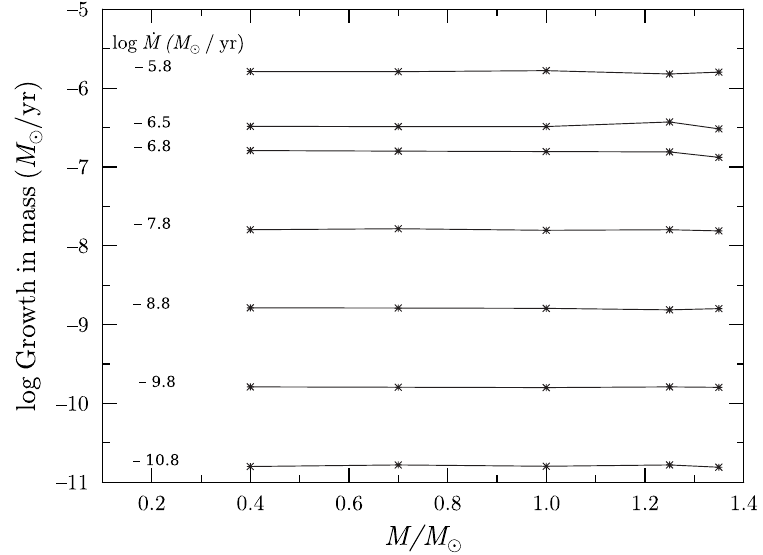
Fig. 2. The log of the difference between the mass accreted and the mass lost. We display the log of the growth in mass (in units of M ⊙ yr − 1 ) as a function of WD mass for each of our simulations. Each point is the amount of accreted (less ejected) mass divided by the time to reach the TNR for the given simulation. The lines connect the points for the same ˙ M and we give the log of ˙ M along a column on the left of the